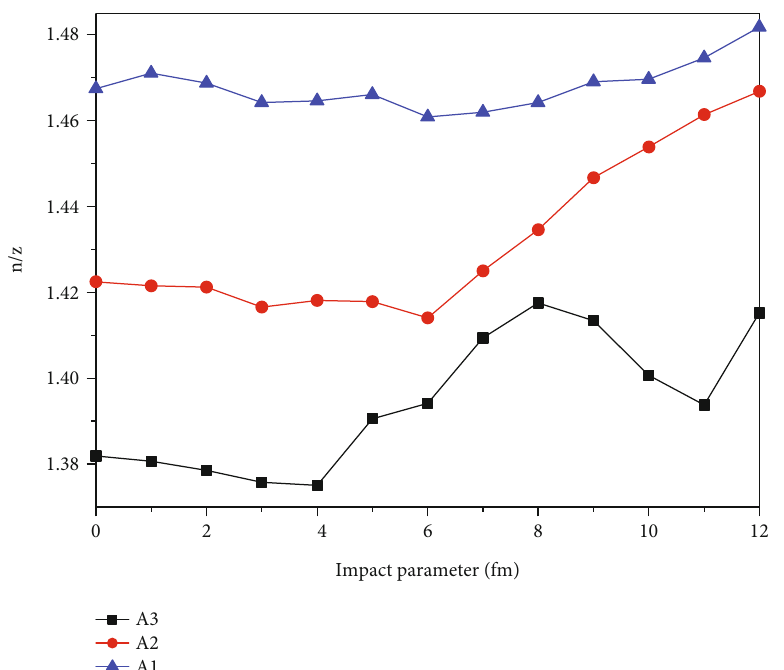
Figure 4: The dependence of the ratio of neutrons to protons on the impact parameter in 197 Au+ 197 Au system at